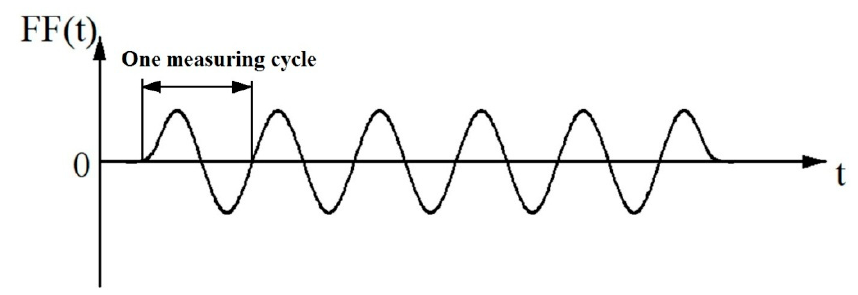
Figure 7. Typical curve of friction force, FF( t ): friction force vs. time.